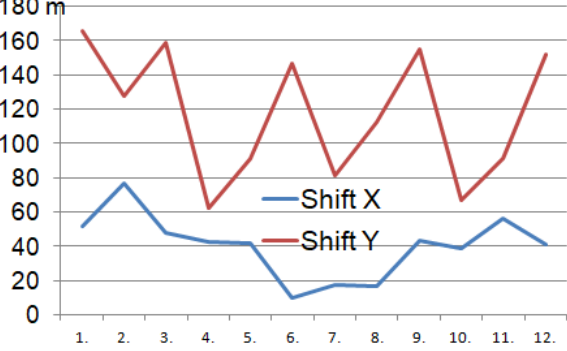
Figure 8: Shifts in RPC-orientations versus GCPs, frame 2 of data set 6, SkySat SSC12, 12 Basic Panchromatic scenes with 3199 x 1349 pixels of 5.2 µm